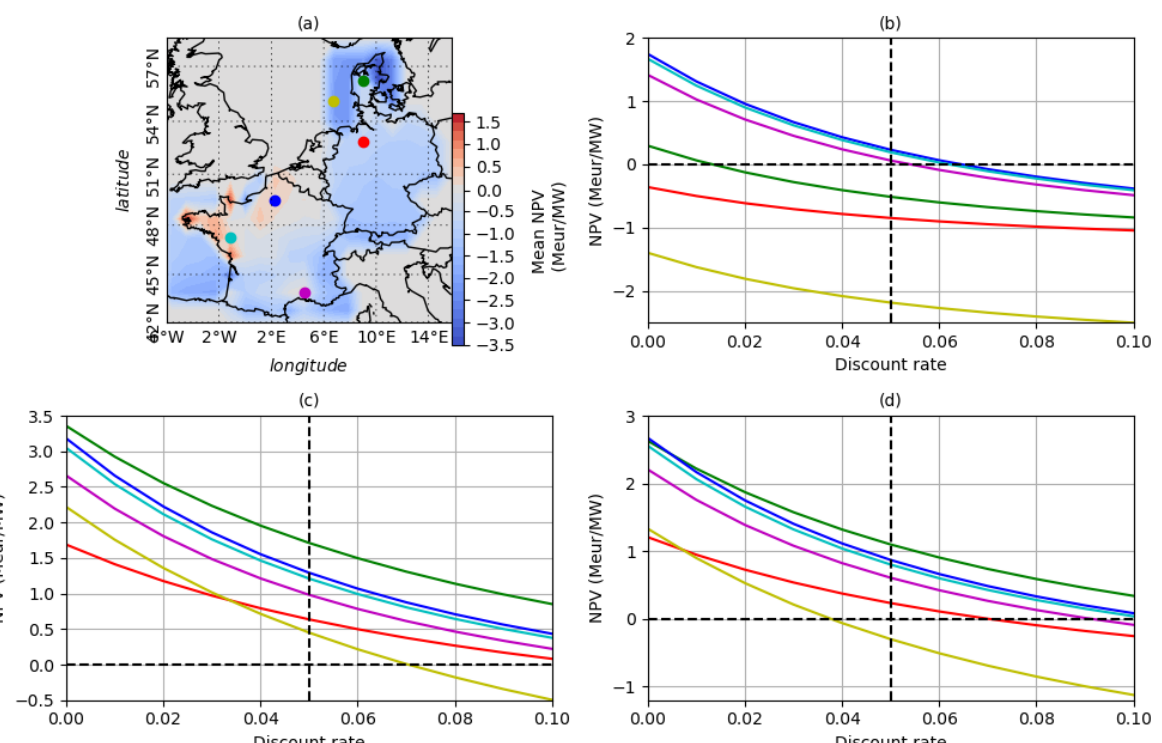
Figure A5. ( a ) Map of the mean NPV value for wind farms not supported by mechanism, with r = 0.05 (same as Figure 7a), the coloured points correspond to the curves in the sensitivity plots ( b – d ). ( b ) Mean NPV in case of no support mechanism as a function of the discount rate for the 6 locations plotted in ( a ); ( c , d ) same as ( b ) but for wind farms supported by FIT and FIP mechanisms, respectively. Each colored line segment in graphs (b), (c) and (d) corresponds to the location of the same color in graph